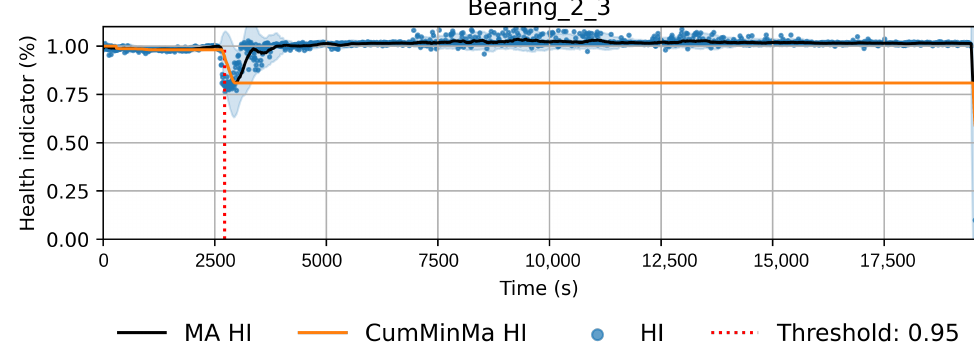
Figure 8. HI of bearing 2_3 recovers from a drastic event around time step 2500. In order to account for these types of events, the cumulative minimum is extracted as a